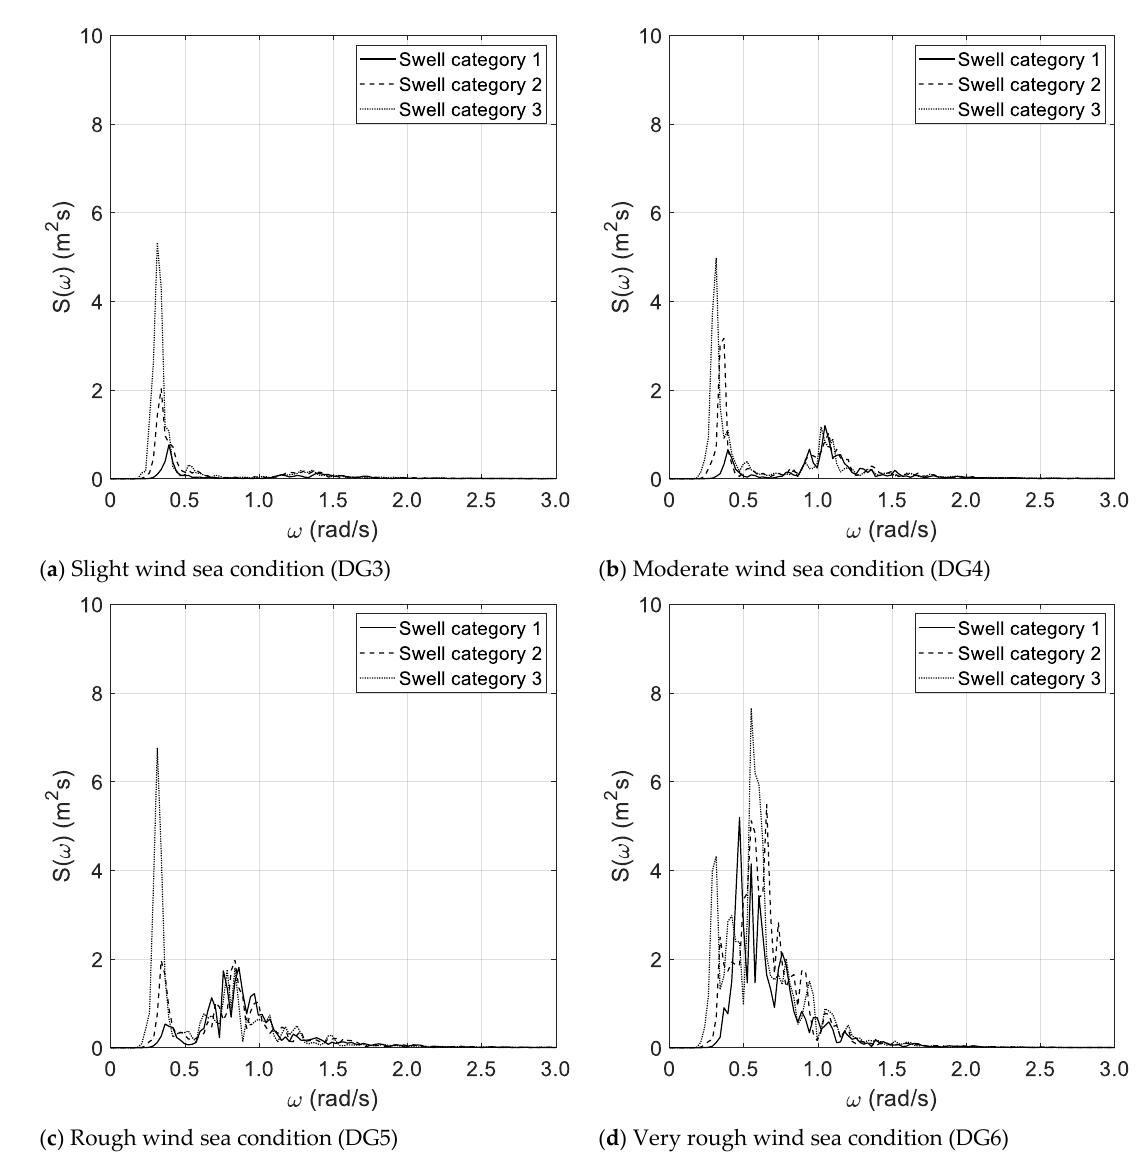
Figure 7. Spectral analysis (Welch)—short duration with high frequency resolution. Table 3. Sea state assessment (Thomson)—long duration.